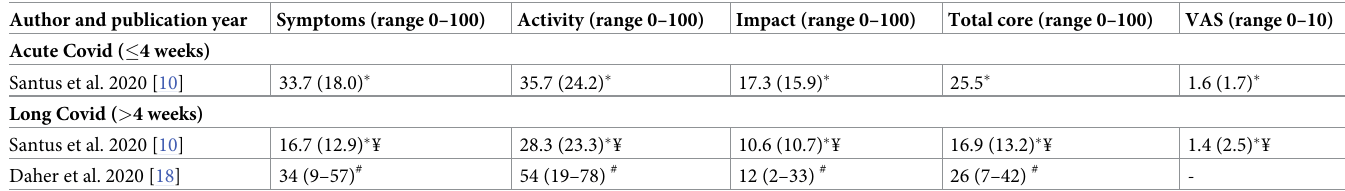
Table 5. SGRQ scores reported in included studies (Acute Covid and Long